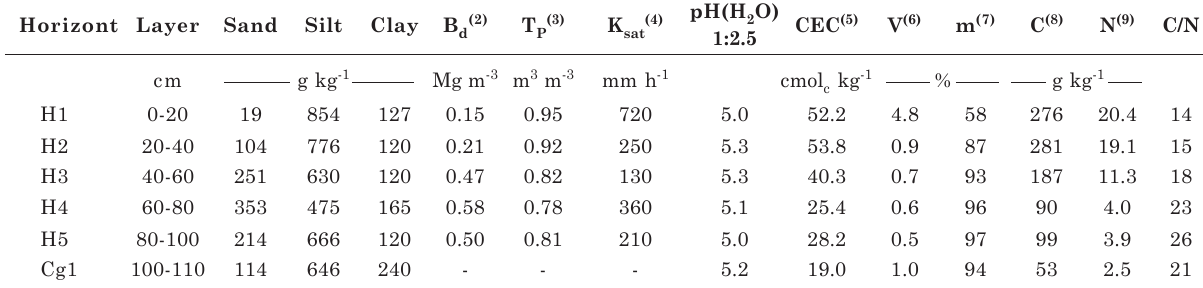
Table 1. Physical and chemical properties of a Typic Haplosaprist, flat topography, subtropical waterlogged montane grassland. Data were obtained from a trench and a set of five replications for the horizons H1 to H3, four for H4 and two for